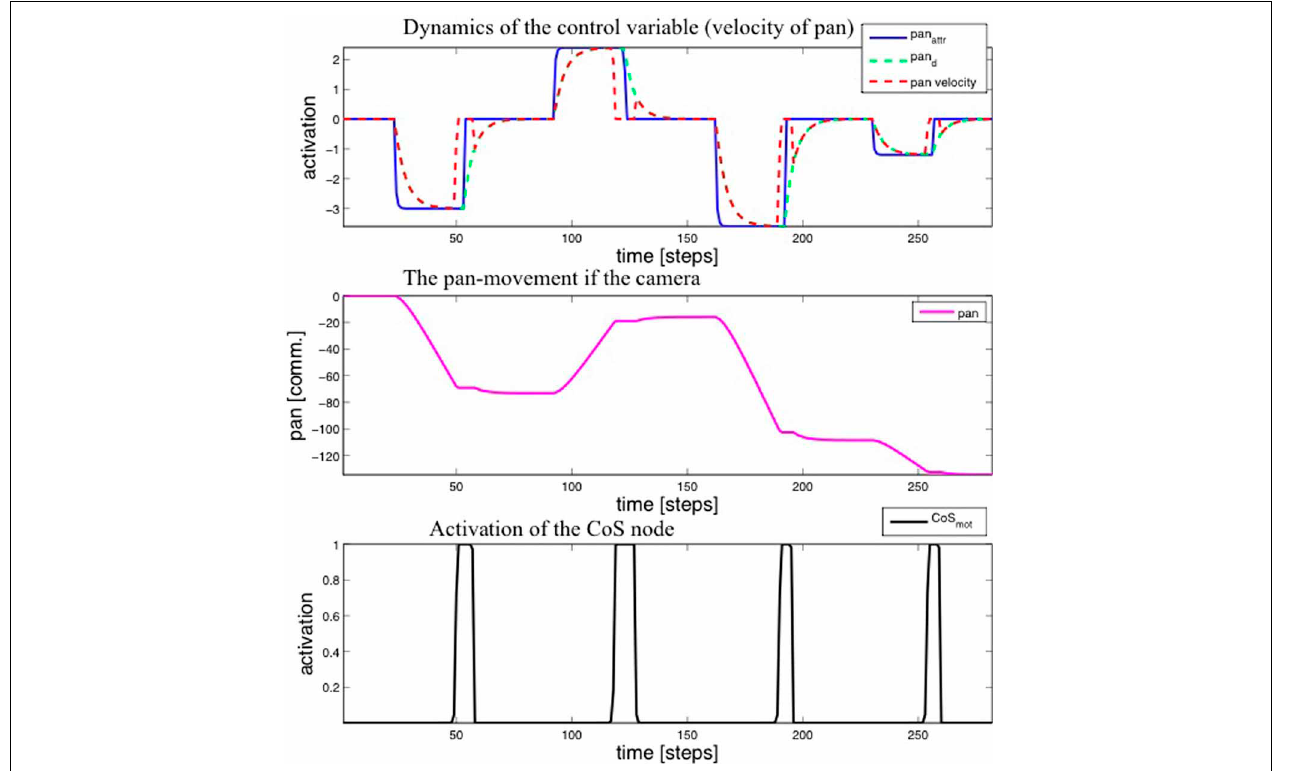
FIGURE 7 | Top: Time-course of the activation of the motor variable (velocity of the pan joint) during four steps of the learning procedure. Middle : The value of the pan variable. Bottom : Activation of the CoS node.